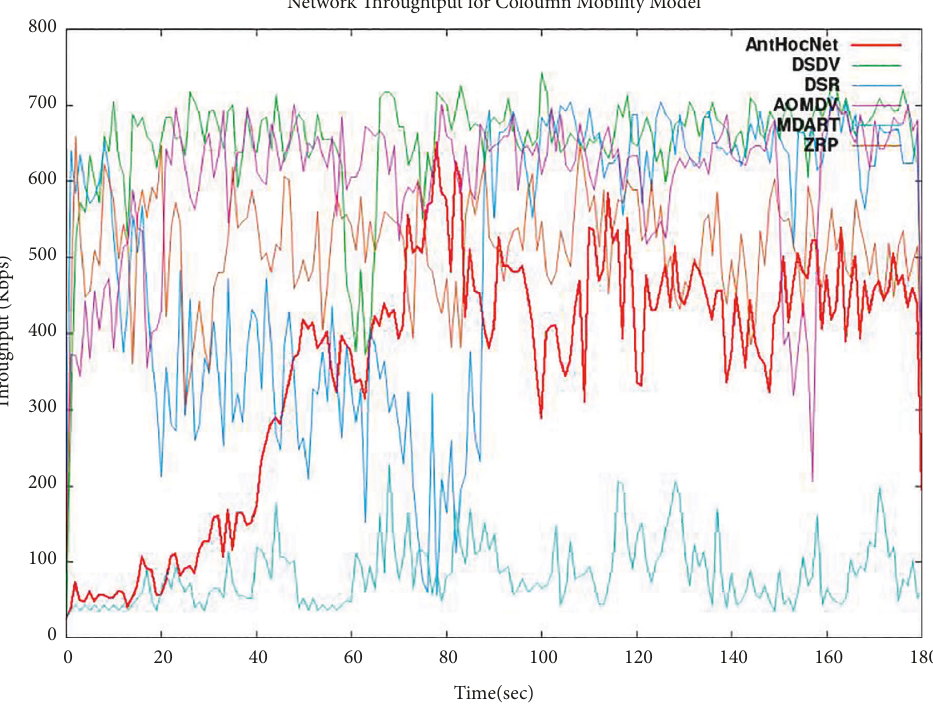
Figure 5: Network throughput for column mobility model using routing protocols.